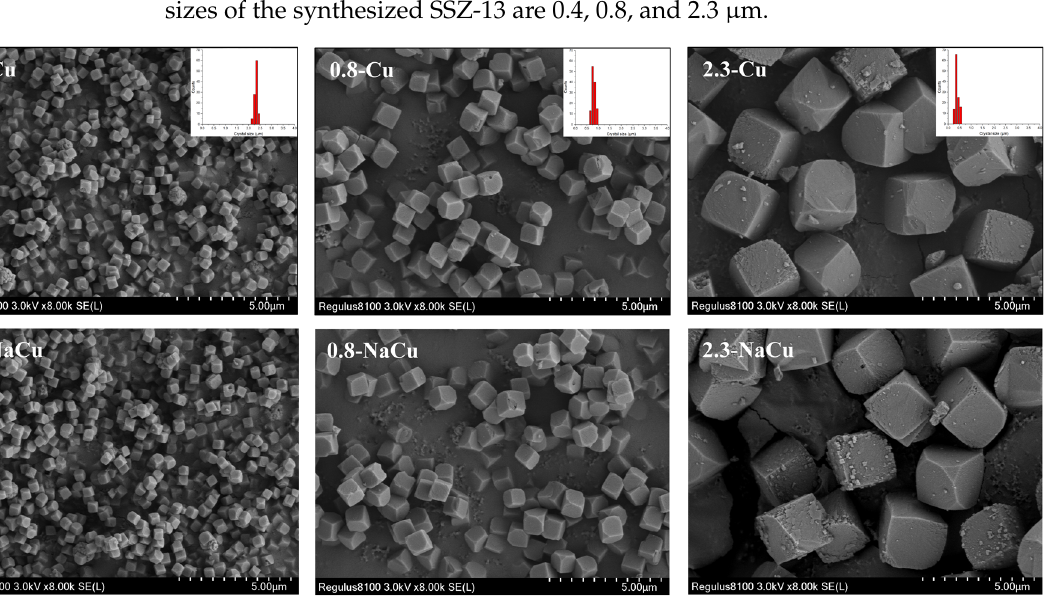
Figure 1. SEM images of Cu/SSZ-13 catalysts with different crystal